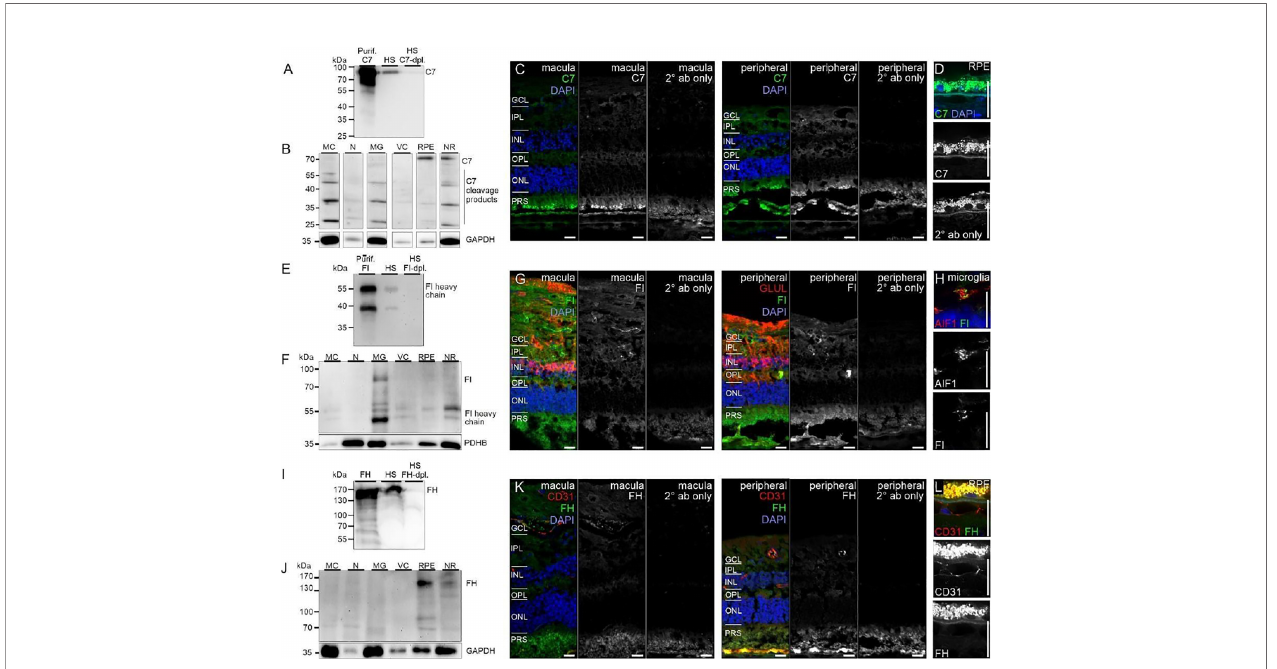
FIGURE 6 | CFI, CFH and C7 protein expression in the human retina. (A) Loading puri fi ed C7 or human serum (HS), full length C7 was detected as a single band (~90 kDa) and cleavage products <90 kDa. (B) Full-length C7 was detected at low levels in puri fi ed cell types, but robustly in RPE/choroid. Cleavage products were detected in all cell populations. C7 immunoreactivity was similar in macular and peripheral retinal sections. (D) Higher magni fi cation of the C7 staining in RPE. (E) Loading puri fi ed CFI or HS, only the CFI heavy chain (~50 kDa) was unequivocally detected by Western blot. (F) CFI was present in Müller cells (MC), microglia (MG), vascular cells (VC) and RPE/choroid, but not in neurons. (G) Comparable CFI-labeling of structures of the macular and peripheral retina. CFI-immunoreactivity partially overlapped with that of the Müller cell marker glutamine synthetase (GLUL). (H) Higher magni fi cation of the inner plexiform layer (IPL) demonstrating co- localization of CFI with IBA1-positive microglia. (I) Detection of CFH (~150 kDa) by Western blot using puri fi ed CFH and HS. (J) CFH was only detected in RPE/ choroid. A contamination with CFH from the system circulation cannot be excluded. (K) CFH immunoreactivity was con fi ned to vessel lumens. (L) Minor CFH immunoreactivity at the RPE – Bruch ’ s membrane interface at higher magni fi cation. (B, F, J) PDHB or GAPDH (Glyceraldehyde-3-phosphate dehydrogenase) served as housekeepers. N, neurons; NR, whole neuroretina. (C, D, G, H, K, L) GCL, ganglion cell layer; OPL, outer plexiform layer; ONL, outer nuclear layer; PRS, photoreceptor segments. Scale bars, 20